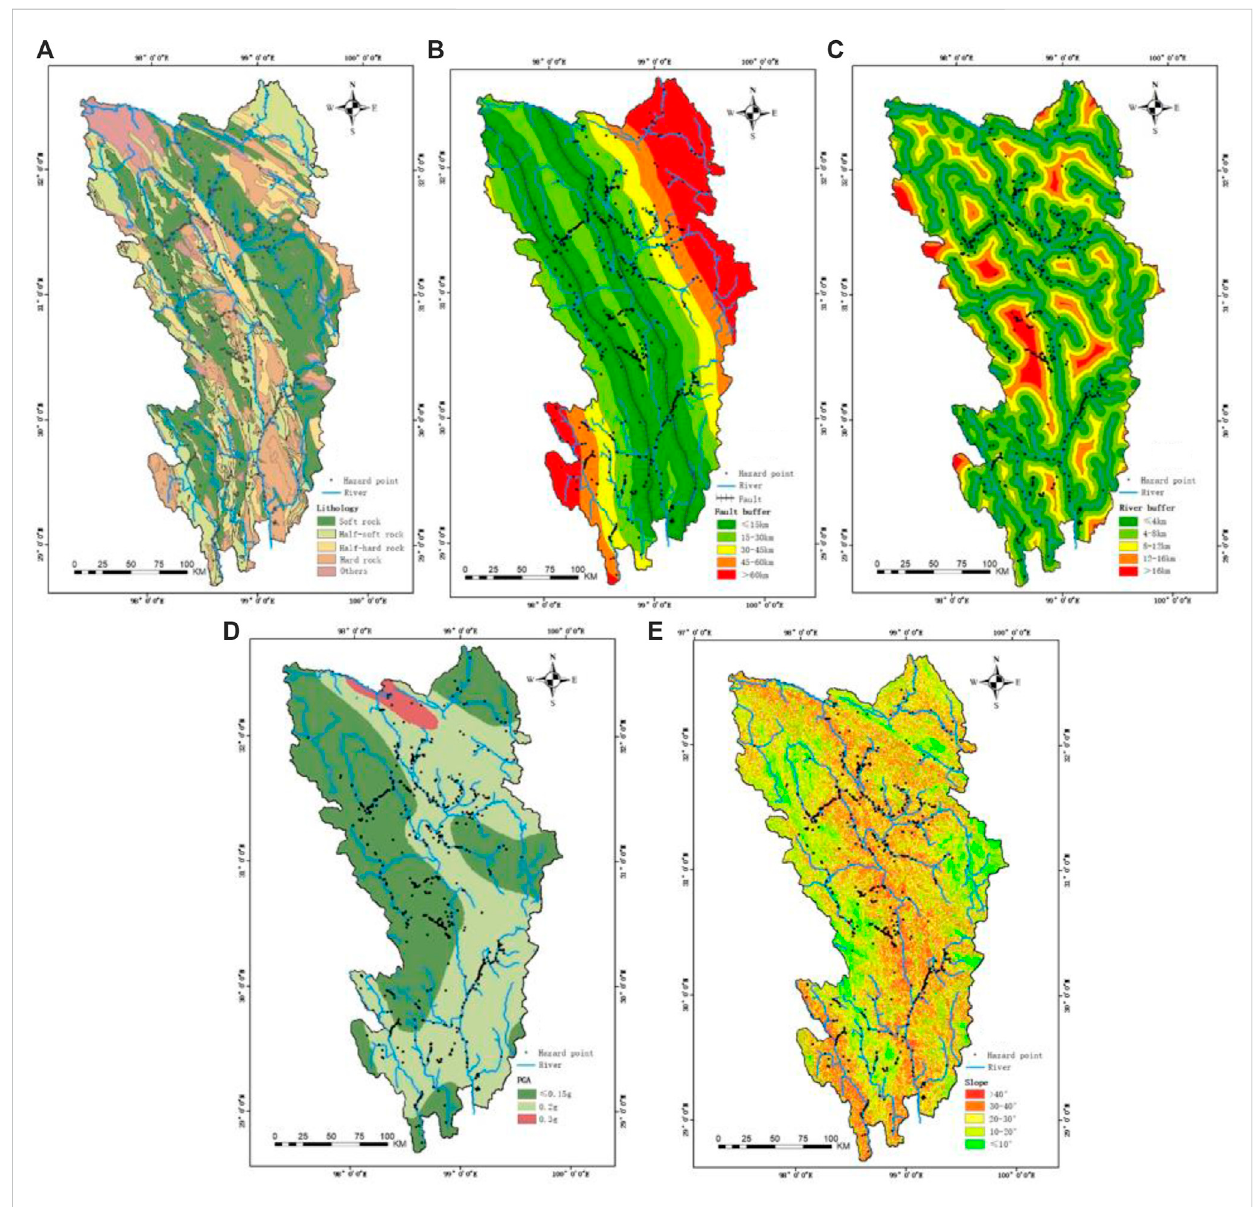
Factor distribution in the study area: (A) lithology, (B) fault, (C) river, (D) PGA, and (E)